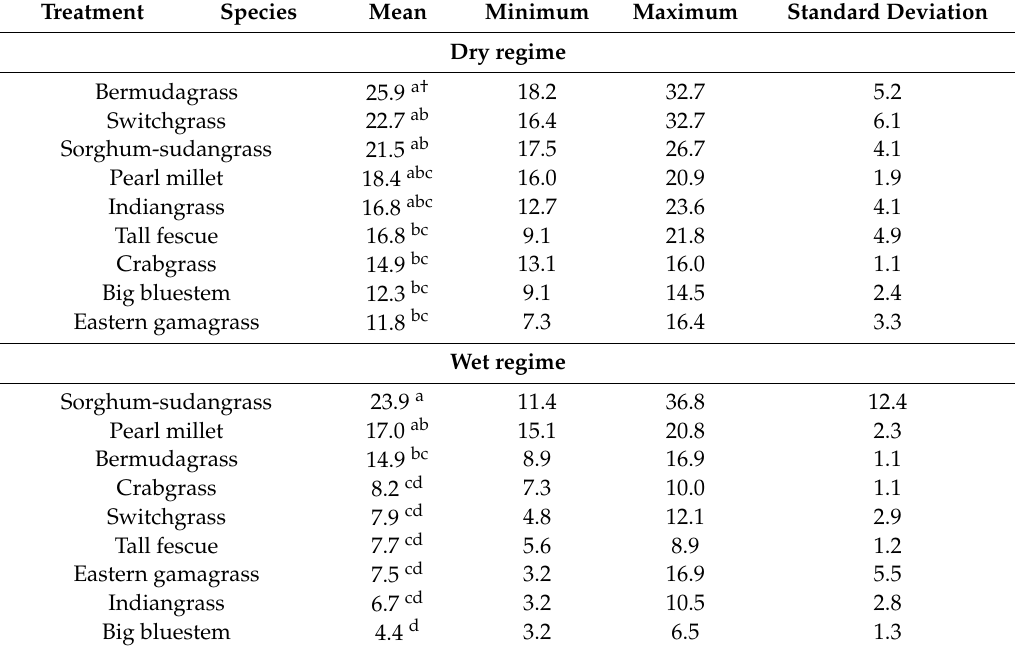
Table 2. Least square means mWUE (g DM kg − 1 H 2 O) of each species averaged across four sampling dates, University of Tennessee, Knoxville, TN greenhouse, 2013. Species di ff ered between dry (60% water-holding capacity) and wet (90% water-holding capacity) treatments ( p < 0.0001). Values are comparable for both the dry and wet treatments by column ( n = 16 per species).